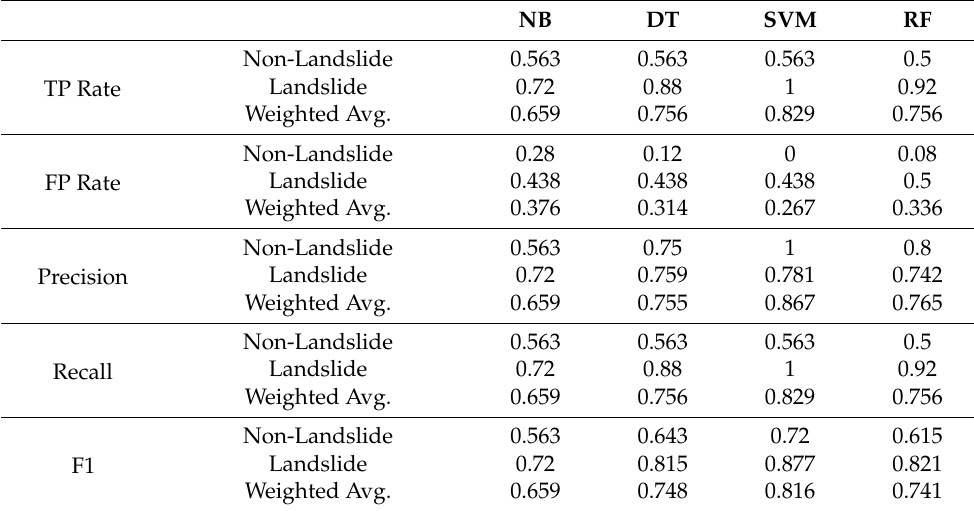
Table 7. Accuracy index results of different algorithms.